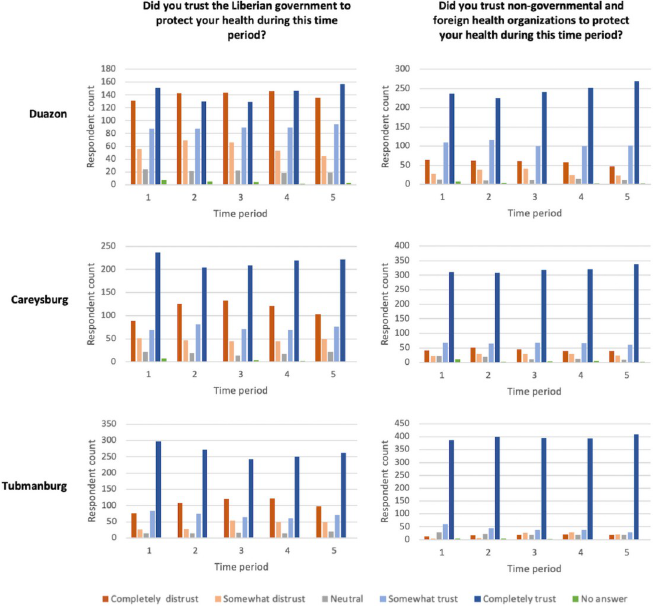
Fig 2. Change over time in trust in government and iNGOs in each of three study locations: Duazon (peri-urban, high Ebola exposure), Careysburg (rural, low exposure), and Tubmanburg (urban, high incidence). Time period 1 = before Ebola came to Liberia, Jan 2014; Time period 2 = between 1st case in Lofa and 1st case in Monrovia; Time period 3 = between 1st case in Monrovia and quarantine in West Point; Time period 4 = between quarantine in West Point and the end of 2014; Time period 5 = beginning of 2015 as last cases of Ebola occurred and schools opened.